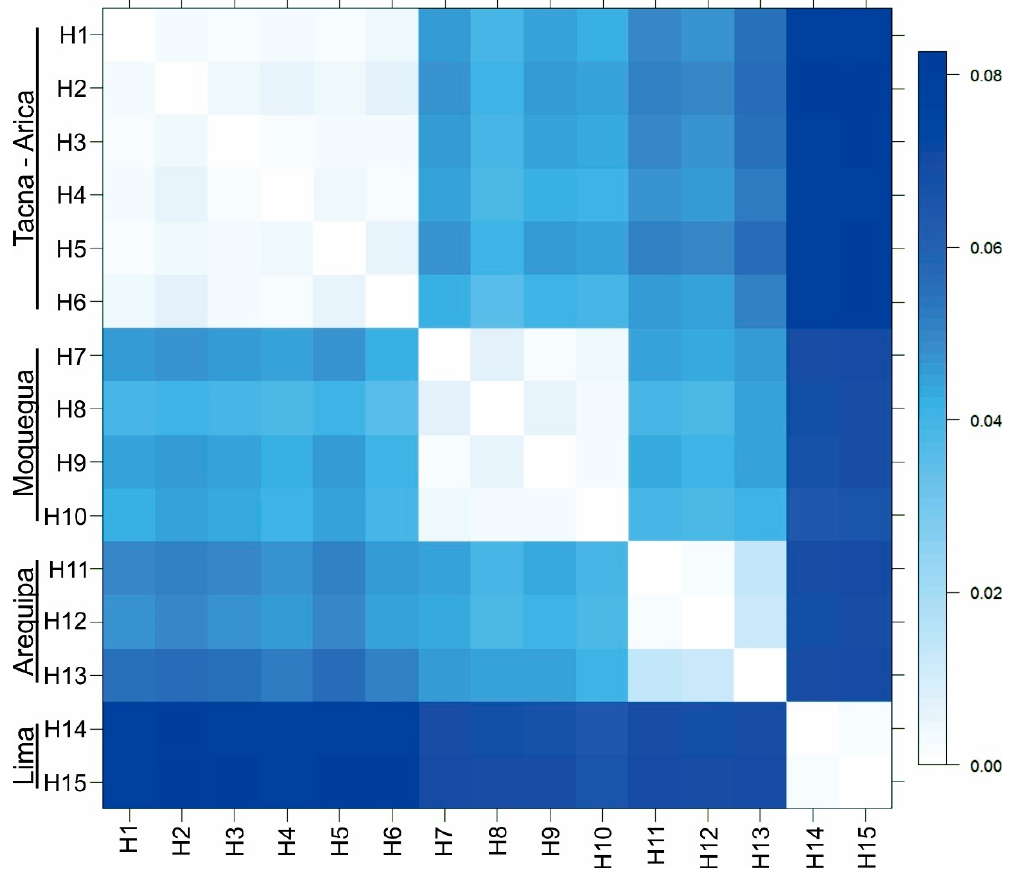
Figure 3. Genetic distance (K2P) matrix between COI haplotypes (657 bp) of Angelabella ordered according to spatial clusters suggested by Geneland. Tacna-Arica group represents A. tecomae , the type species of the genus.